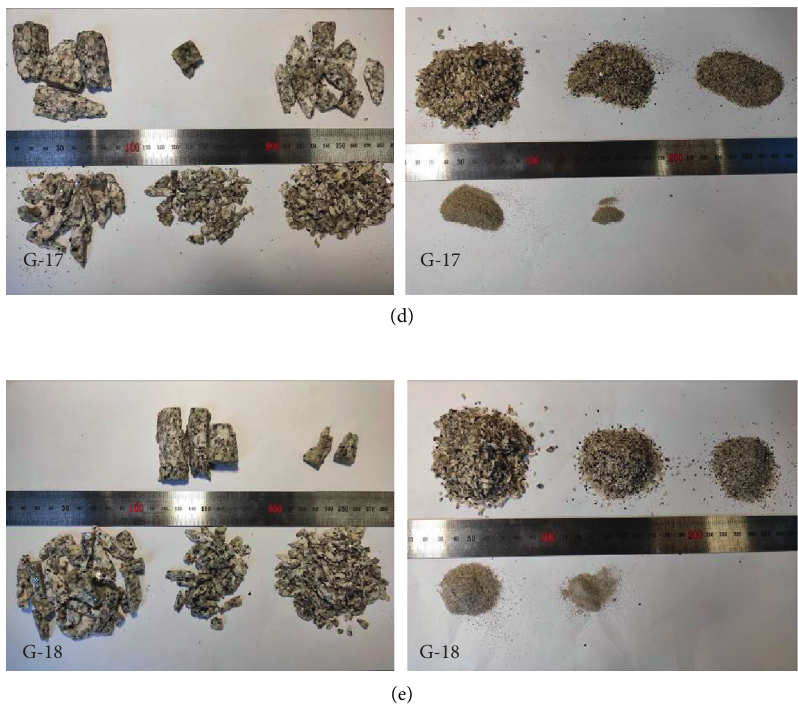
Figure 10: Fragments at different mesh sizes: (a–e) specimens G-11, G-14, G-15, G-17, and G-18.